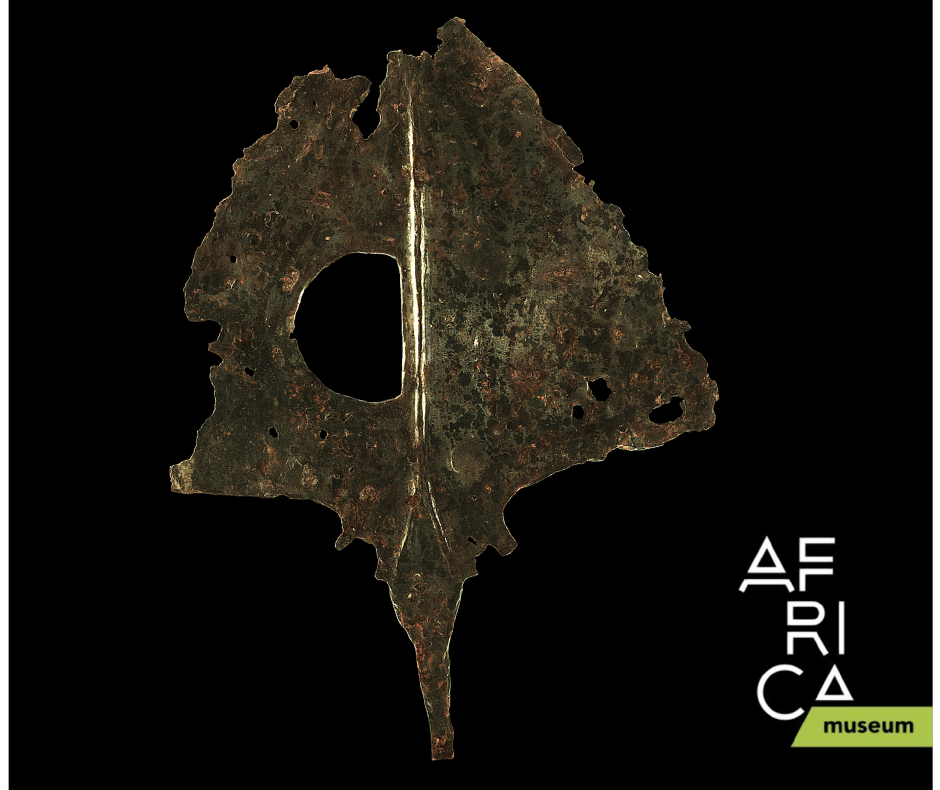
Fig. 3.28. 10 th -century ceremonial axe from the necropolises of the Upemba Depression in Katanga (DRC), scanned with Mechscan https://sketchfab.com/models/8638588190bd4d3e88b857e7d94fc4cc